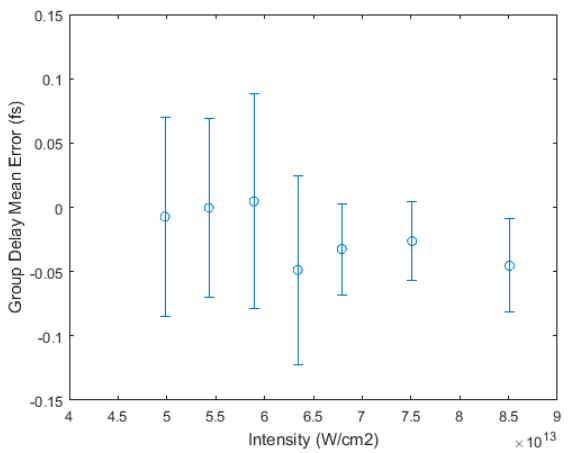
Figure A2. Mean error from the SFA fit in methane (CH 4 ). By applying the SFA fit to the lowest-intensity RABBITT data, and by scaling further calculations relative to the known input power, we found that six of the seven SFA calculations in methane were, within error bars, of zero deviation from the experimental results, in spite of the calculation being designed to treat the atomic potential. The only outlier at 8.51×10 13 W/cm 2 sits 1.25 standard deviations from zero.